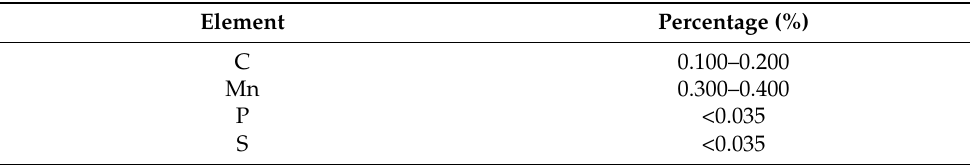
Table 2. Chemical compositions of the C-shape carbon steel specimen.